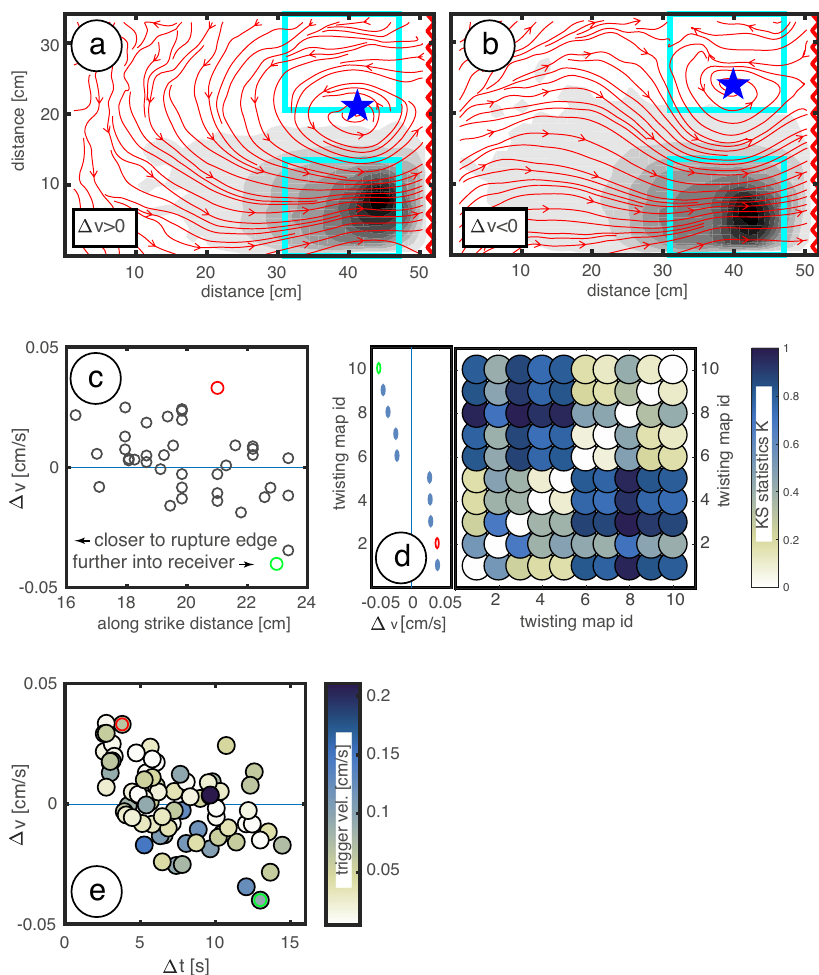
Fig. 3 Twisting accelerates and decelerates receiver kinematics. a , b Coseismic displacement pattern highlighted by streamlines, showing twisting about a vertical axis for both positive and negative Δ vs. Arrows indicate a counterclockwise circulation. The gray background shading represents the rupture (see also Supplementary Fig. 13 showing the velocity fi eld during both interactions). c Bivariate plot showing the relationship between the location of twisting centers and Δ v. d Kolmogorov – Smirnov statistic K computed for all combinations of couples of twisting maps with the largest Δ v ( Δ v reported on the subplot to the left). K highlights the degree of similarity between couples of coseismic displacement maps. Light and dark blue color indicate similar and dissimilar couples of twisting maps, respectively. e Bivariate plot showing the relationship between Δ v and Δ t over multiple segment interactions. Circles are color-coded by the amplitude of the velocity peak of the triggering asperity. Markers highlighted by green and red circles correspond to displacement maps shown in panels a and b ,